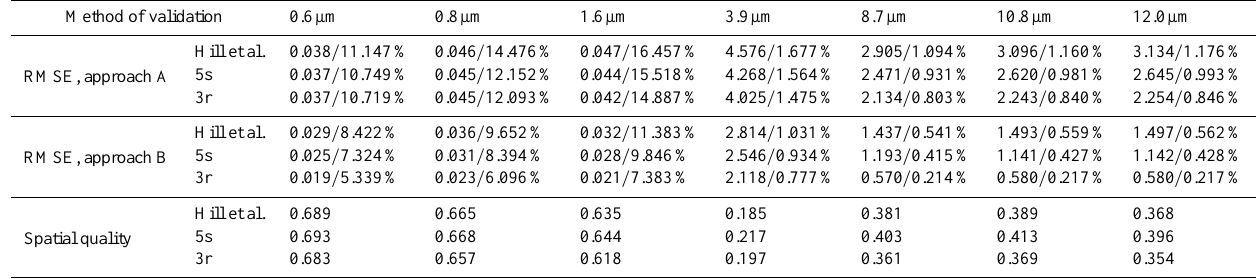
Table 2. Validation results for the spectral and spatial quality of different variations of the pan-sharpening approach. The RMSE is given in absolute values (Reflectance for solar channels, blackbody temperature for thermal channels) as well as in% of the mean pixel value of each validated